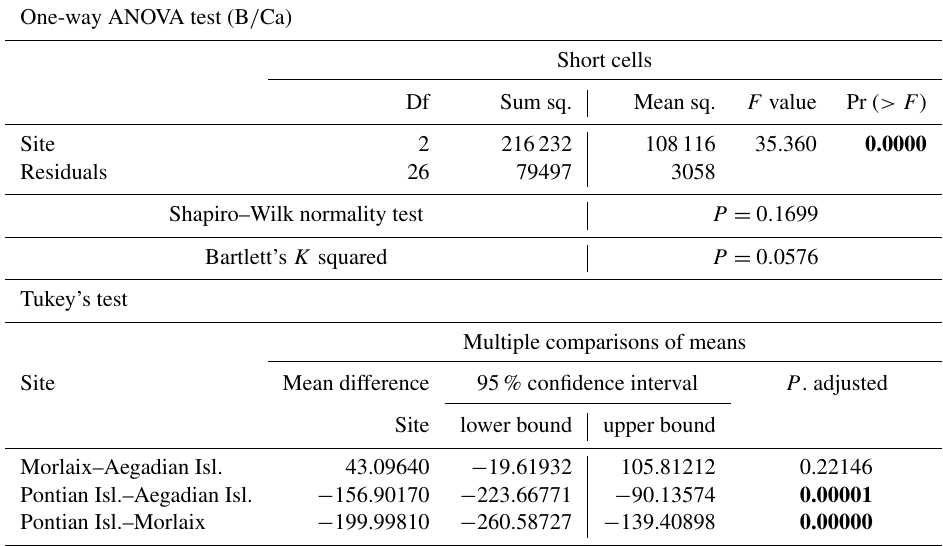
Table A5. Results of statistical tests performed to evaluate the differences of B / Ca in the short cells of L. corallioides collected at different sampling sites. Statistically significant p values are given in bold. ANOVA test significance at α = 0 . 05; Tukey’s test significant at p ≤ α